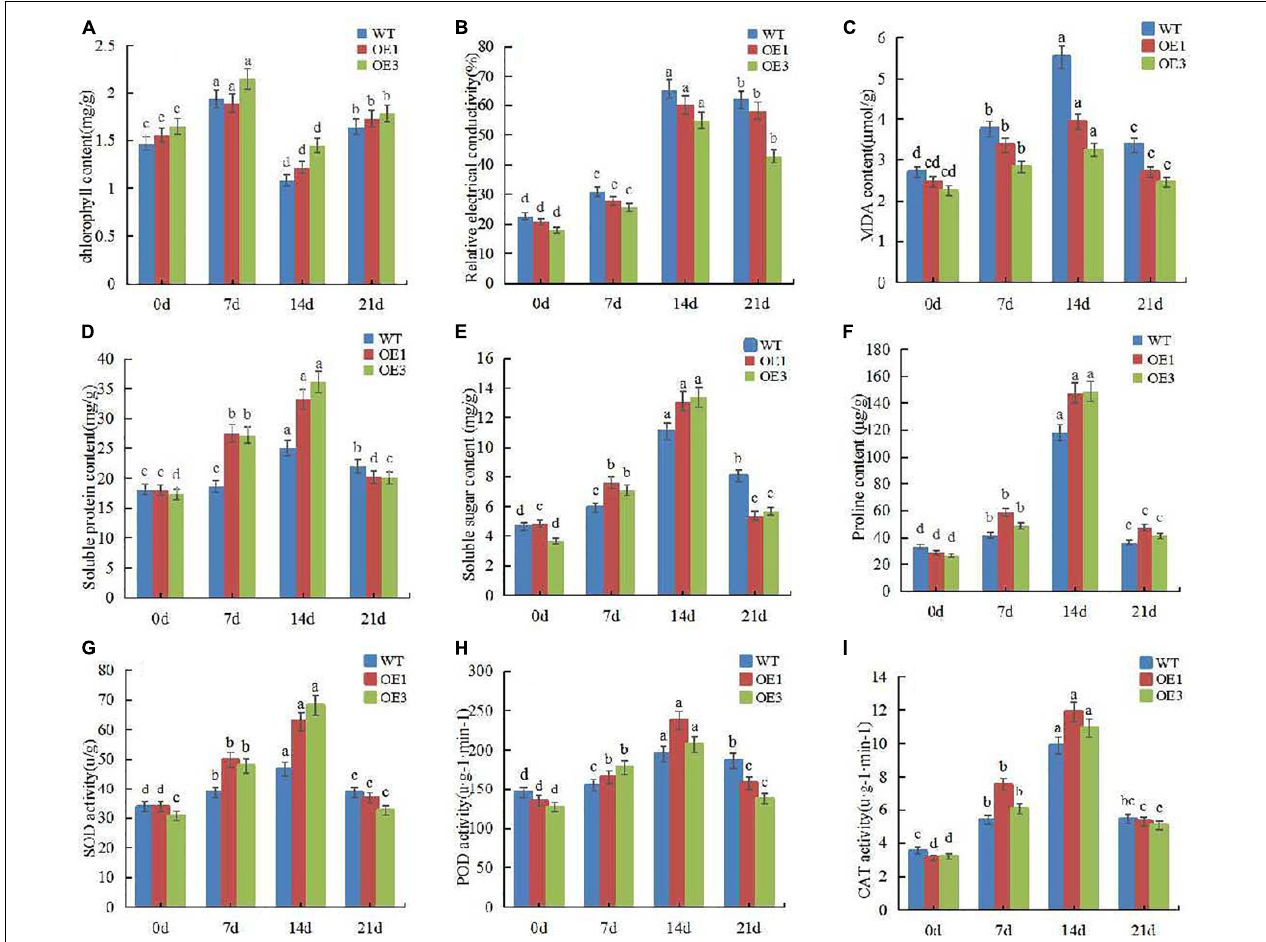
FIGURE 3 | Determination of various physiological indexes of tomato leaf receiving 150 mM NaCl followed by no-salt watering after 14 days. (A) Chlorophyll content of leaf under 150 mM NaCl and rewatering. (B) Relative conductivity of leaf under 150 mM NaCl and rewatering. (C) MDA content of leaf under 150 mM NaCl and rewatering. (D) Soluble protein content of leaf under 150 mM NaCl and rewatering. (E) Soluble sugar content of leaf under 150 mM NaCl and rewatering. (F) Proline content of leaf under 150 mM NaCl and rewatering. (G) SOD activity of leaf under 150 mM NaCl and rewatering. (H) POD activity of leaf under 150 mM NaCl and rewatering. (I) CAT activity of leaf under 150 mM NaCl and rewatering. Different lower-case letters indicate significant differences between means as measured by ANOVA followed by Duncan’s multiple range test ( P < 0.05, the same